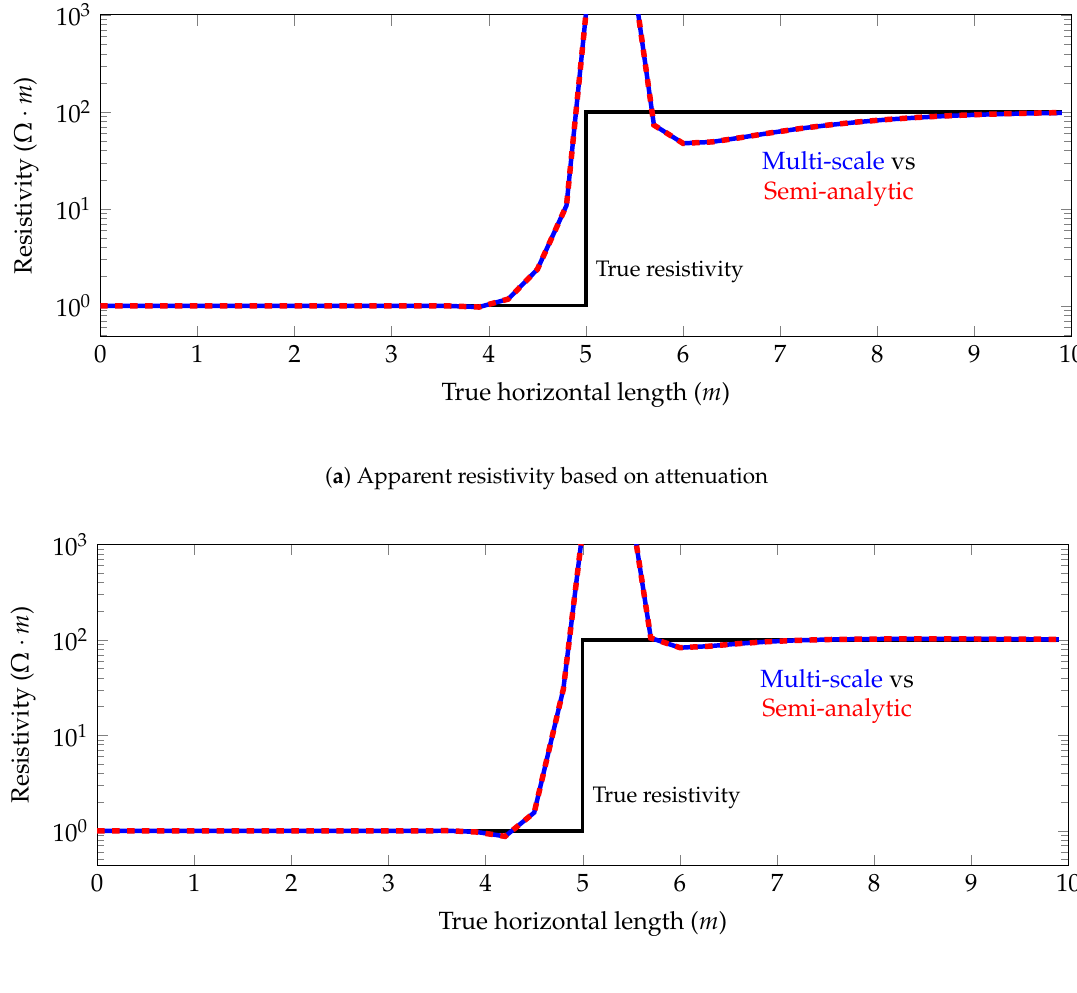
Figure 9. Model problem 1. Apparent resistivity for the zz coupling for a 89 ◦ deviated well.